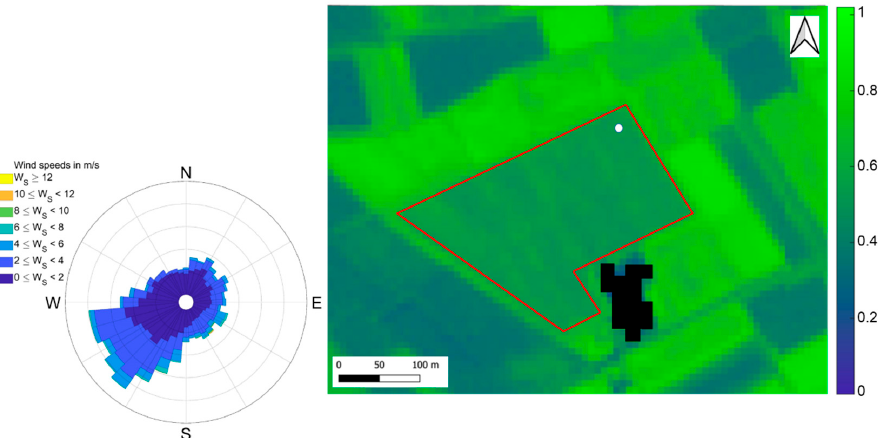
Figure 1. Normalized Difference Vegetation Index (NDVI) Sentinel-2 image of the short-rotation coppice (SRC) plantation in Lochristi acquired on 7 July 2016, at 10 m resolution. The red polygon is the area of the plantation. The same area was extracted for calculating VIs. The white dot indicates the location of the flux tower. The black pixels represent the outbuildings. On the left, the wind rose for 2016 representing the wind direction distribution for wind speed classes.